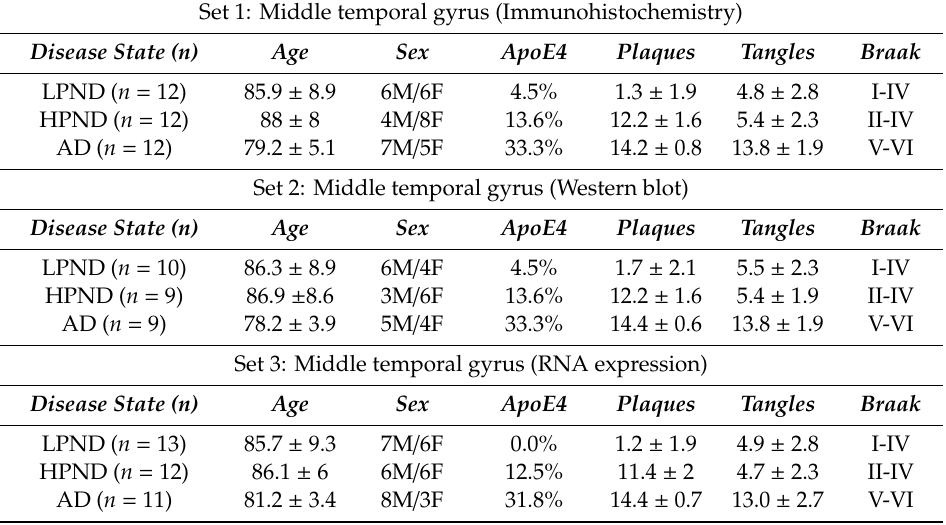
Abbreviations : ApoE4: % ApoE4 alleles; Plaques: mean plaque score + SEM (scale 0–15); tangles: mean tangle score + SEM (scale demented. AD: Alzheimer’s disease 0–15); LPND: low plaque non-demented; HPND: high plaque non-